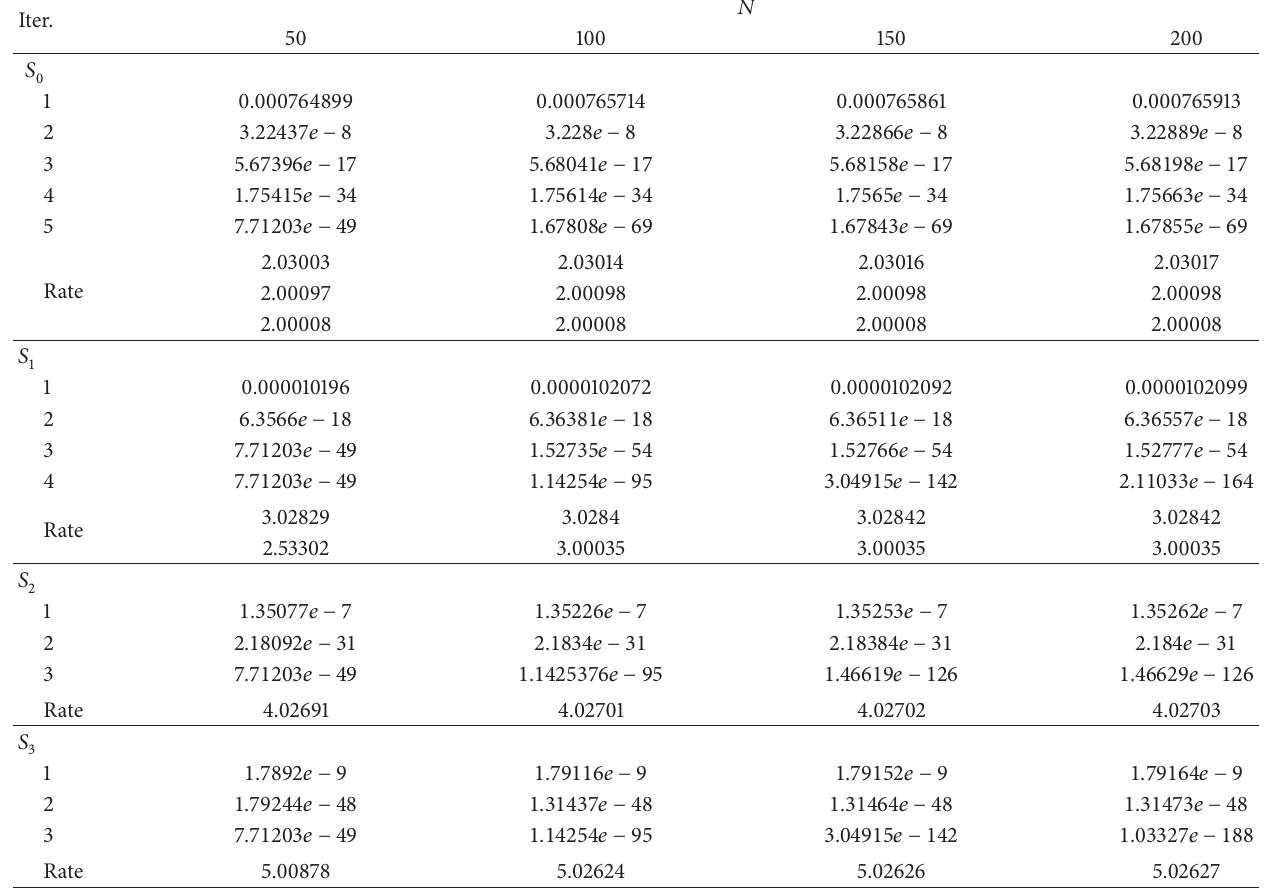
Table 1: Convergence order and absolute error for Bratu problem for 𝜆 = 1 and different values of 𝑁 .